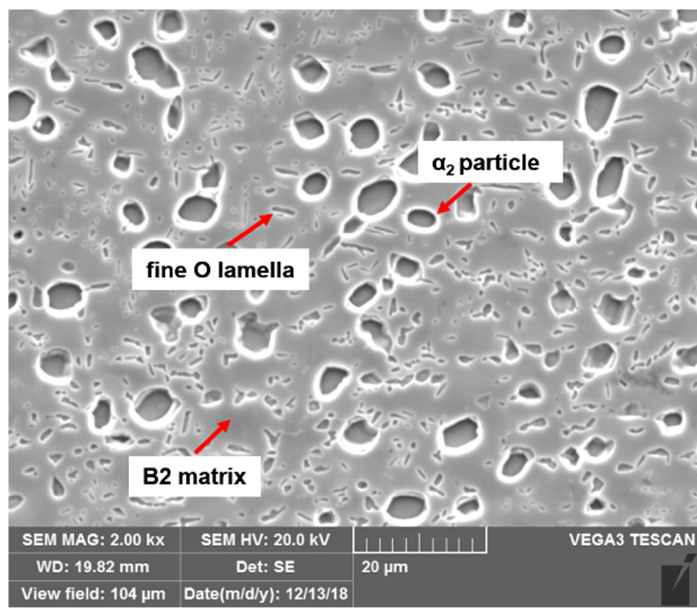
Figure 3. Microstructure of the alloy after solution treatment.